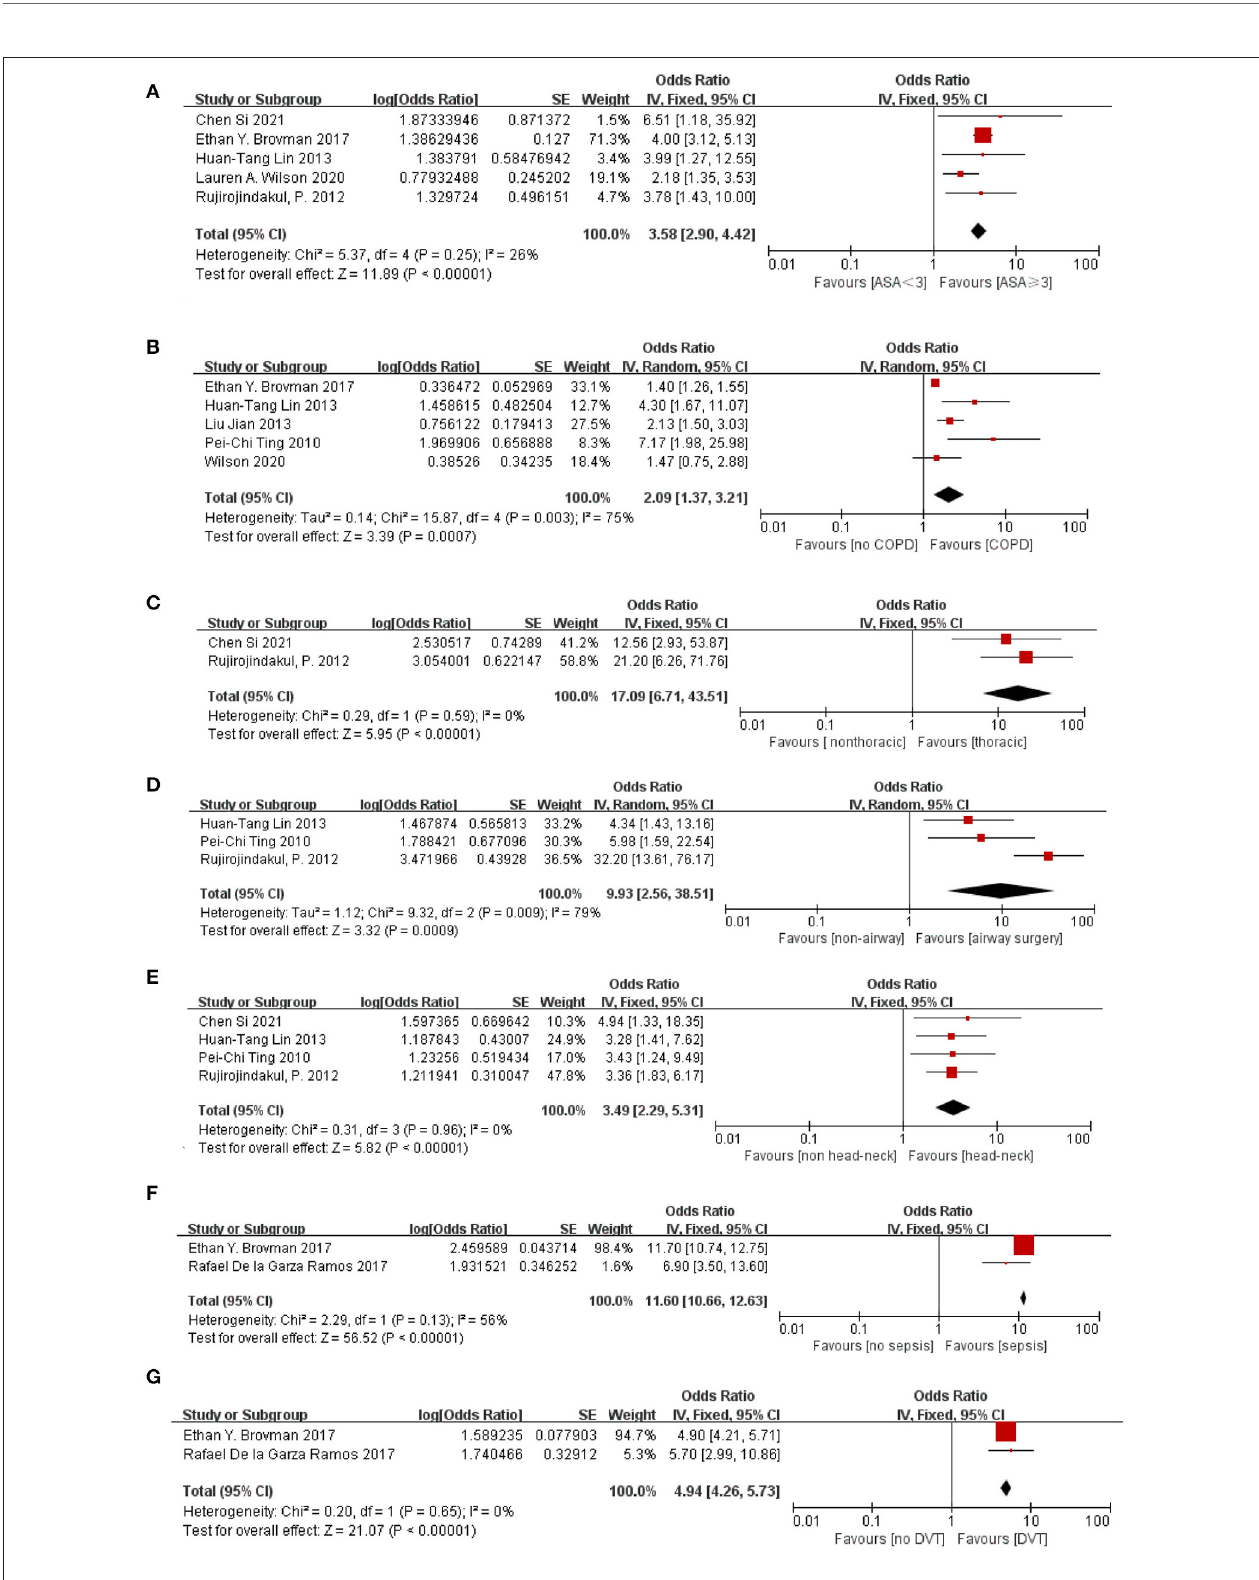
FIGURE 2 | Forest plot of the association between POR after GA and (A) ASA ≥ 3, (B) COPD, (C) thoracic surgery, (D) airway surgery, (E) head-and-neck surgery, (F) sepsis and (G) DVT. The individual block squares denote the OR, the area of the squares is proportional to the weight of each study. The horizontal line represents 95% of the CI. The diamond denotes the pooled estimate and its 95% confidence interval. The diamonds drawn on the right section indicate an increased risk of POR. OR, odds ratio; CI, confidence interval.